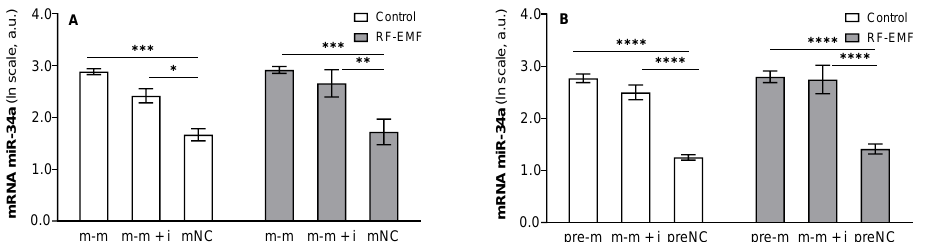
Figure 1. Levels of miR-34a-5p in the DLD1 cells. Cells were transfected with ( A ) miR-34a-5p (m-m), ( B ) pre-miR-34a (pre-m), mimic of mature miR-34a together with the miR-34a inhibitor (m-m + i) or corresponding negative control of mature and pre-miRNA (mNC a preNC, respectively). Data are presented as the mean ± SEM (n = 4) in logarithmic scale. a.u. — arbitrary units. Two-way ANOVA, followed by Tukey ’ s post hoc test, * p < 0.05; ** p < 0.01; *** p < 0.001; **** p < 0.001. oligos and RF-EMF (m-m: F [2, 17] = 3.759, p = 0.067; pre-m: F [2, 17] = 8.143, p < 0.01) and the